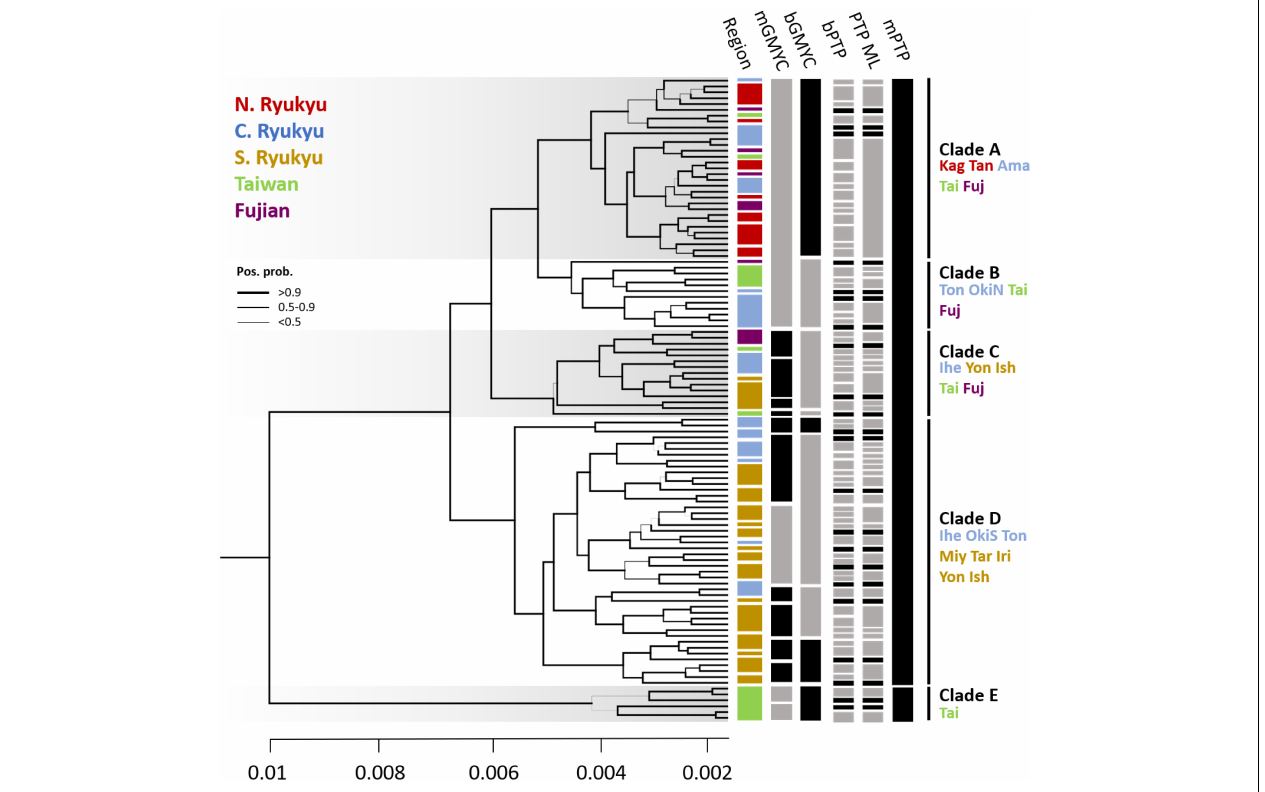
FIGURE 8 | The Bayesian individual tree reconstructed by concatenated restriction site-associated DNA (RAD) loci and the species delimitation results. The branch width indicates the posterior probability. The color bar in each region corresponds to geological regions (i.e., N., C., and S. Ryukyu; Taiwan; and Fujian). For the species delimitation results, the gray bars are posterior probabilities < 0.6. The island names are abbreviated as the first three characters of the full names. OkiN and OkiS represent the northern and southern Okinawa populations, respectively. The bar is unscaled time with a substitution rate equal to